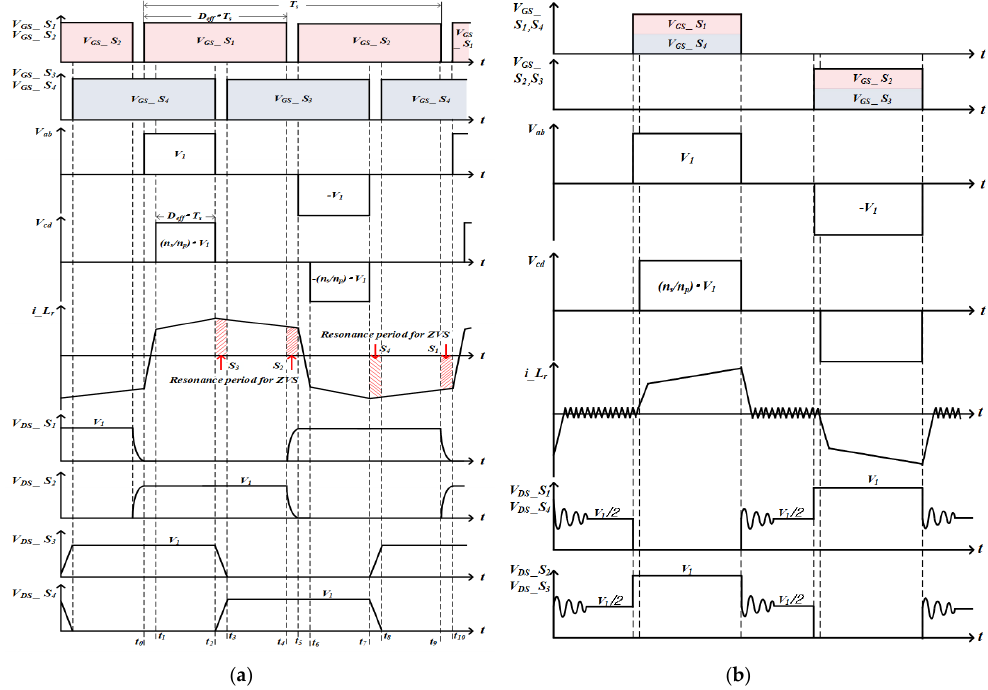
Figure 2. Operational waveforms: ( a ) of conventional phase-shift switching method, ( b ) of conventional pulse-width modulation (PWM) switching method.